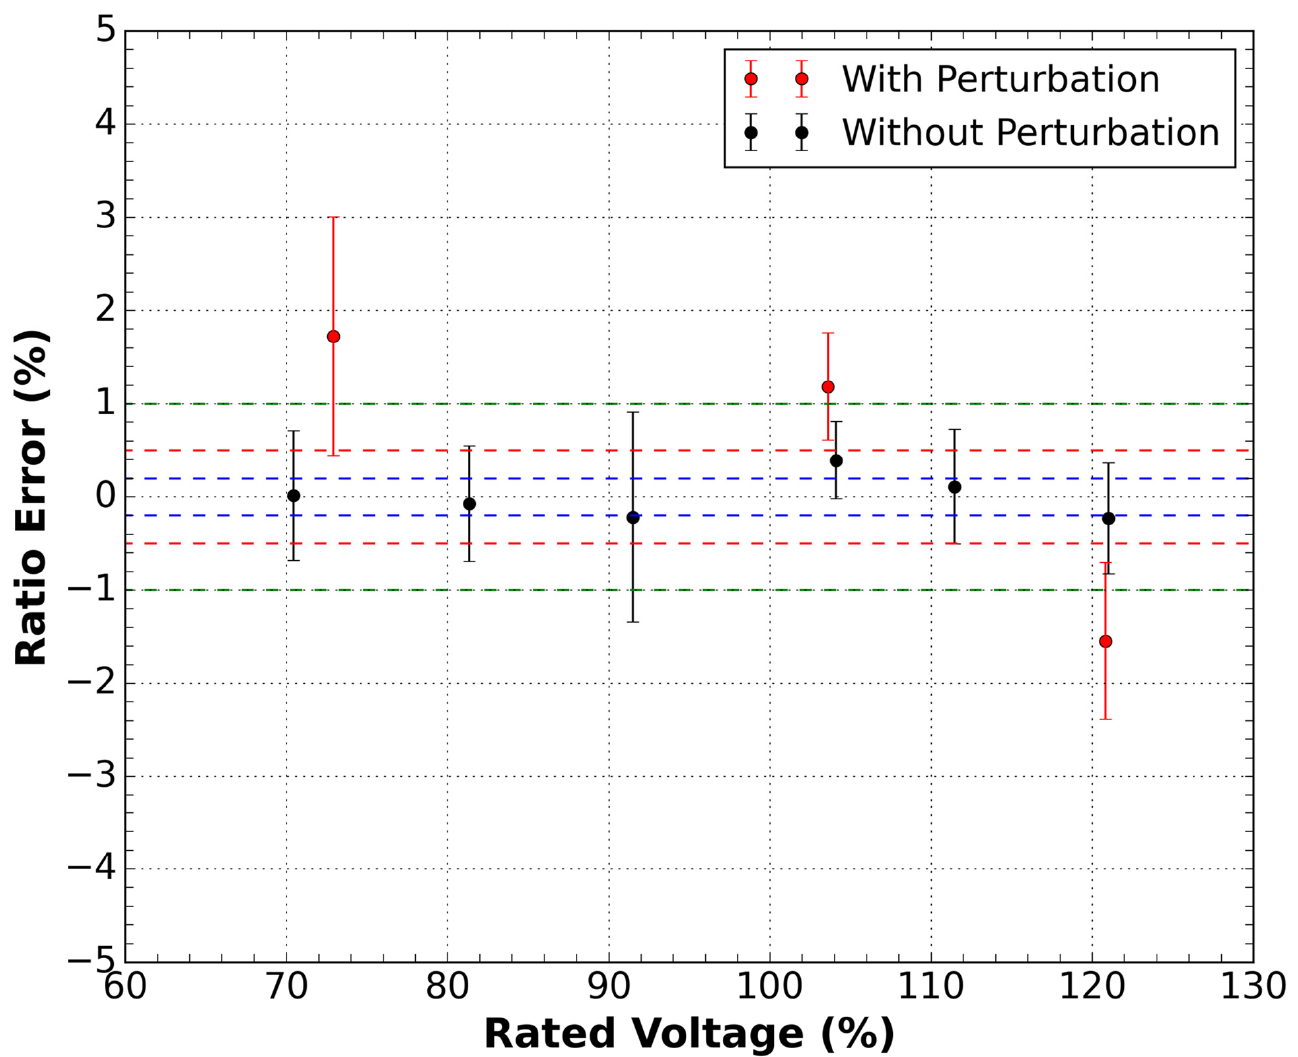
Figure 8. Ratio error measurements as a function of the rated voltage for the sensor outside the DWDM network for the conditions with and without disturbance in the optical cable of the sensor. Green dashed lines are the 1.0 class limits, red dashed lines are the 0.5 class limits, and the blue dashed lines are the 0.2 class limits.